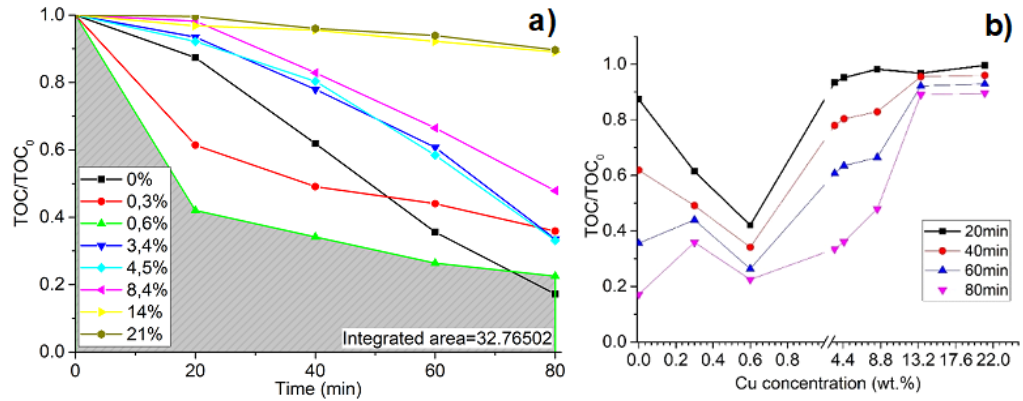
Figure 7. Degradation of oxalic acid in time as a function of Cu concentration in TiO 2 thin films, where ( a ) the degradation of oxalic acid in time at different Cu wt % concentrations and ( b ) the photocatalysis process dependence on Cu wt % dopant concentration .